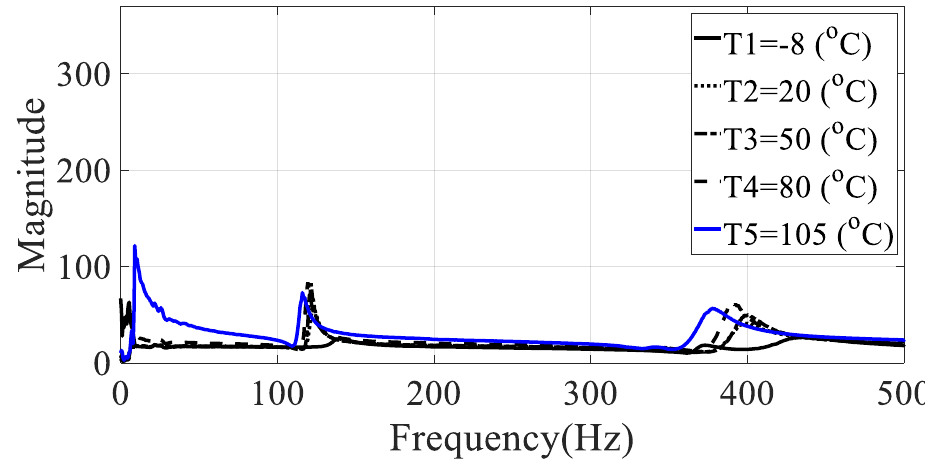
Figure 5. Representative frequency response function of specimen I ( 𝜙 = 0 degrees ).